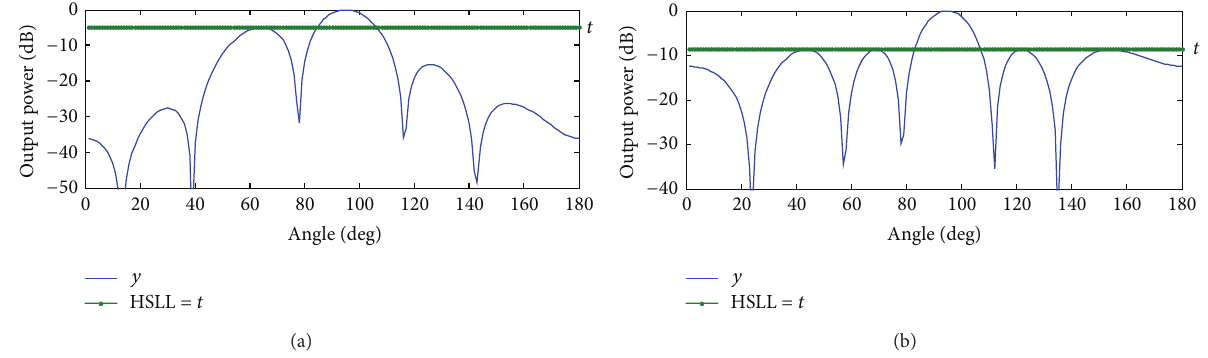
Figure 2: (a) Highest sidelobe level (HSLL = 𝑡 ) is required to be minimized when 𝑁 2 = 6, 𝜃 𝑠 = 95 ∘ ; (b) 𝑦 = AF 2 pattern when highest sidelobe level (HSLL = 𝑡 ) has been minimized for 𝑁 2 = 6, 𝜃 𝑠 = 95 ∘ , and 𝜃 mb = 24 ∘